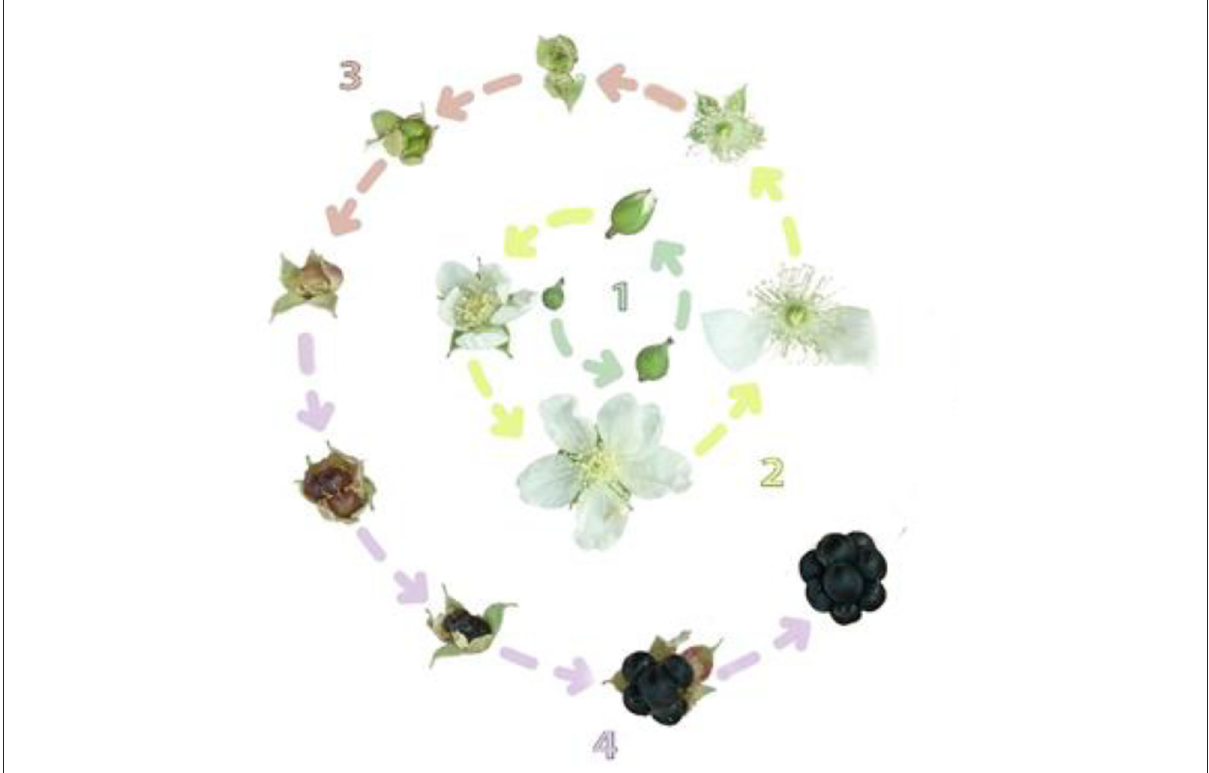
FIGURE1 The life circle of blackberry bloom. 1: bud emergence to anthesis 2: anthesis to petal fall 3: fruit set duration 4: fruit growth duration 5: color development duration.